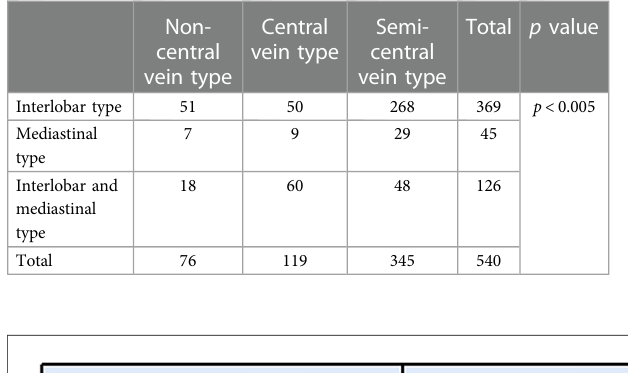
TABLE 9 Distribution of branching patterns in the left superior division veins between different lingular segment artery types.